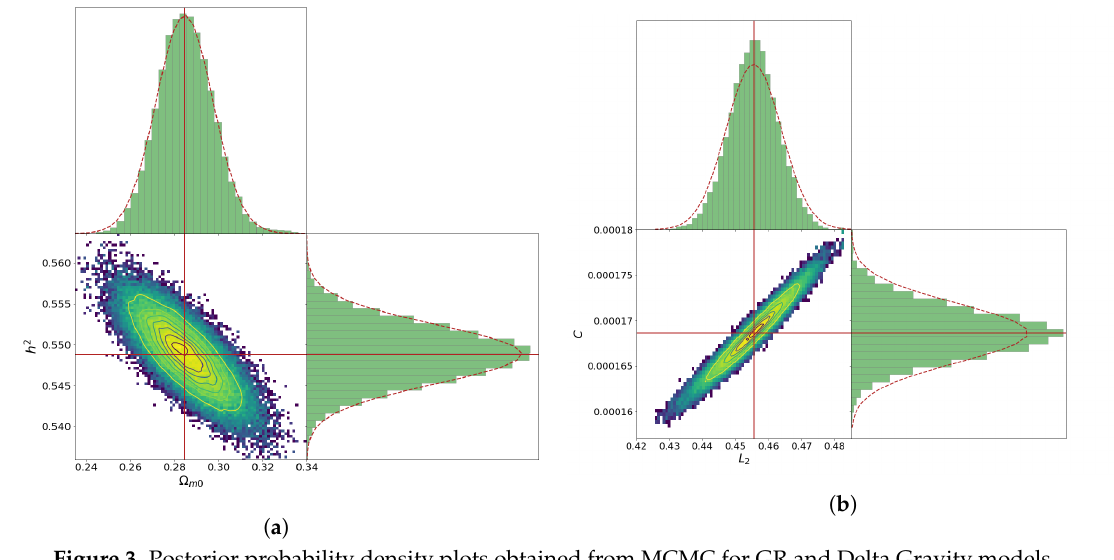
Figure 3. Posterior probability density plots obtained from MCMC for GR and Delta Gravity models. ( a ) Posterior probability density maps with for GR. Combination for Ω m 0 and h 2 . ( b ) Posterior probability density maps for Delta Gravity. Combination for L 2 and C .